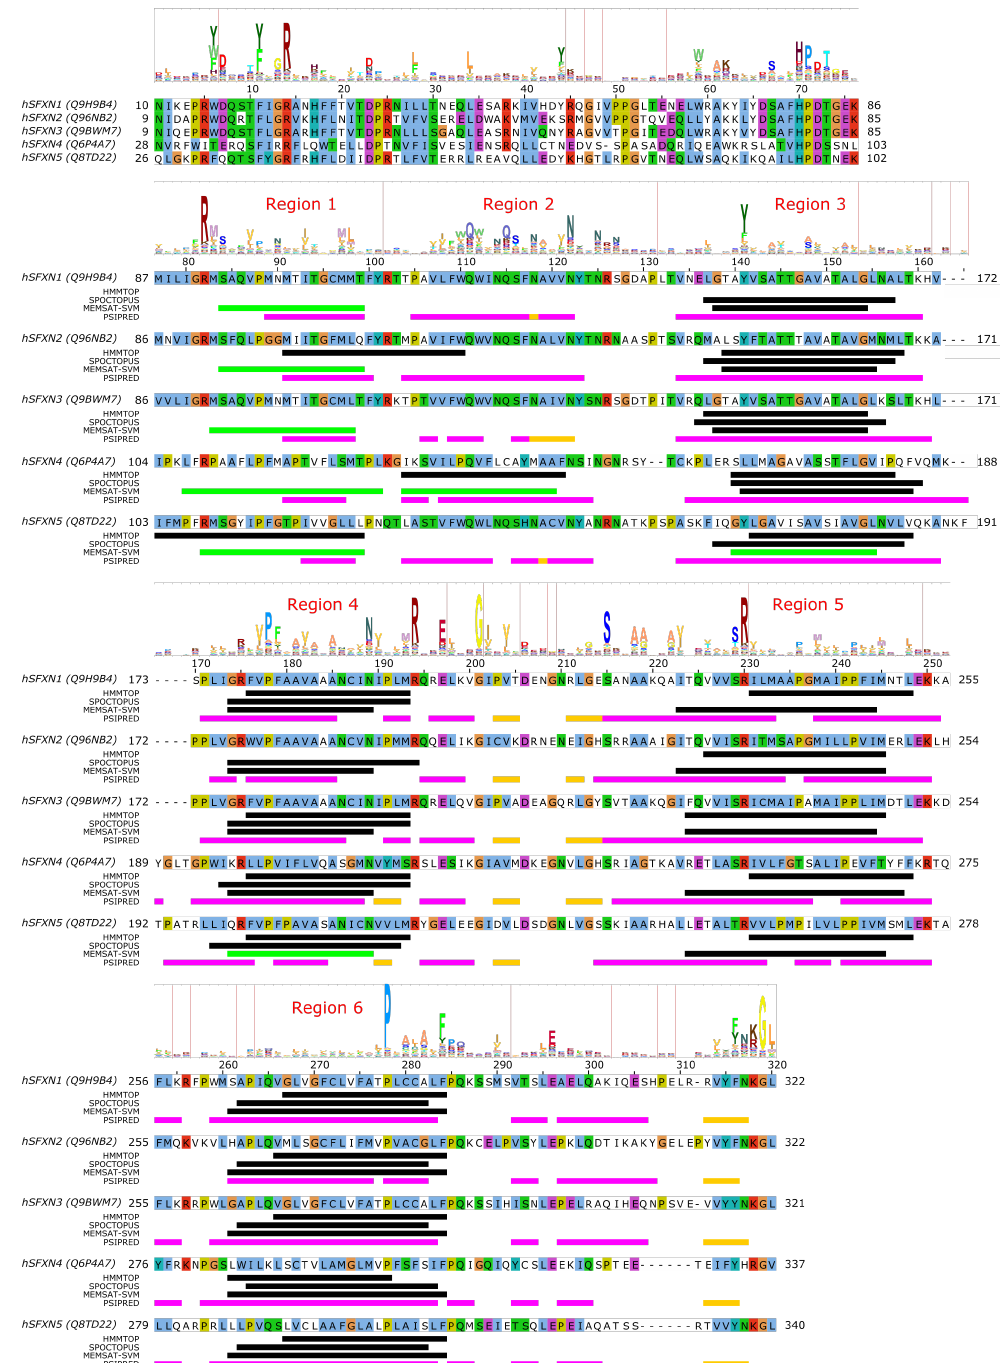
Figure 3. Sequence analysis of human sideroflexin proteins (SLC56 family). The HMM logo is shown above the sequence alignment (see text). Vertical lines in the HMM logo show positions with non-zero insertion frequency. Transmembrane regions predicted by three different methods (HMMTOP, SPOCTOPUS, MEMSAT-SVM) are marked by black lines. Green lines mark transmembrane regions predicted to by pore-lining by MEMSAT-SVM. Secondary structure as predicted by PSIPRED is shown as magenta lines ( α -helix) and golden lines ( β -strand). Uniprot sequence identifiers are shown next to protein names for each